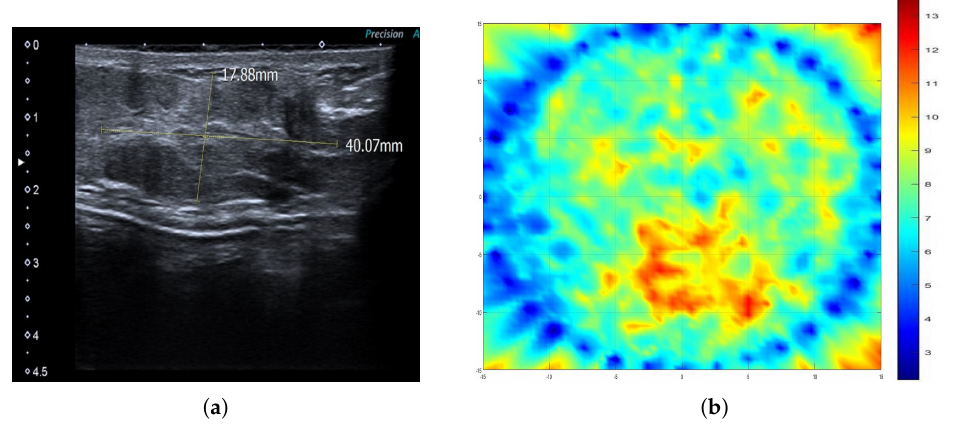
Figure 5. Comparison of SAFE image with clinical ultrasound: ( a ) ultrasound scan showing benign lesion in the left breast and ( b ) SAFE scan showing no concordance with ultrasonography because of air